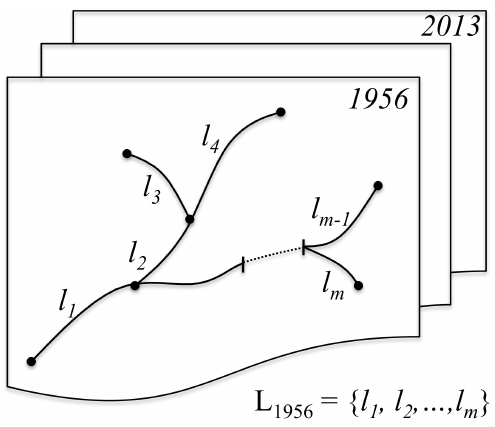
Figure 4. Illustration of the decomposition of the gully network into individual segments for the Monte Carlo-based simulation